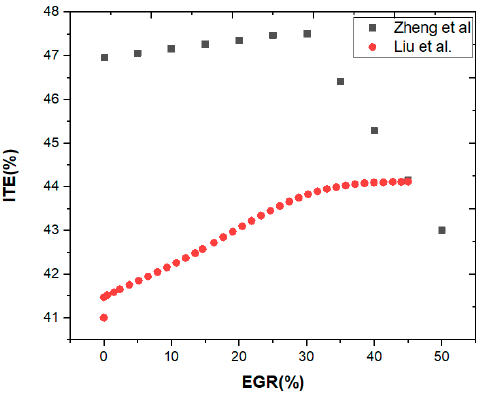
Figure 7. The effect of EGR rate on brake thermal efficiency of diesel engines [116,117].